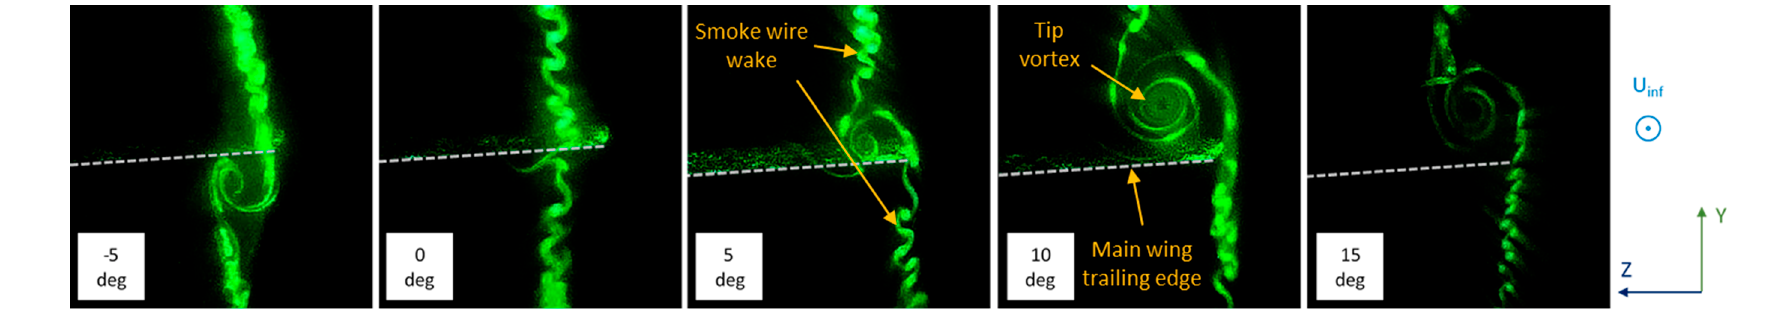
Figure 8. Laser sheet visualization studies at the wingtip.